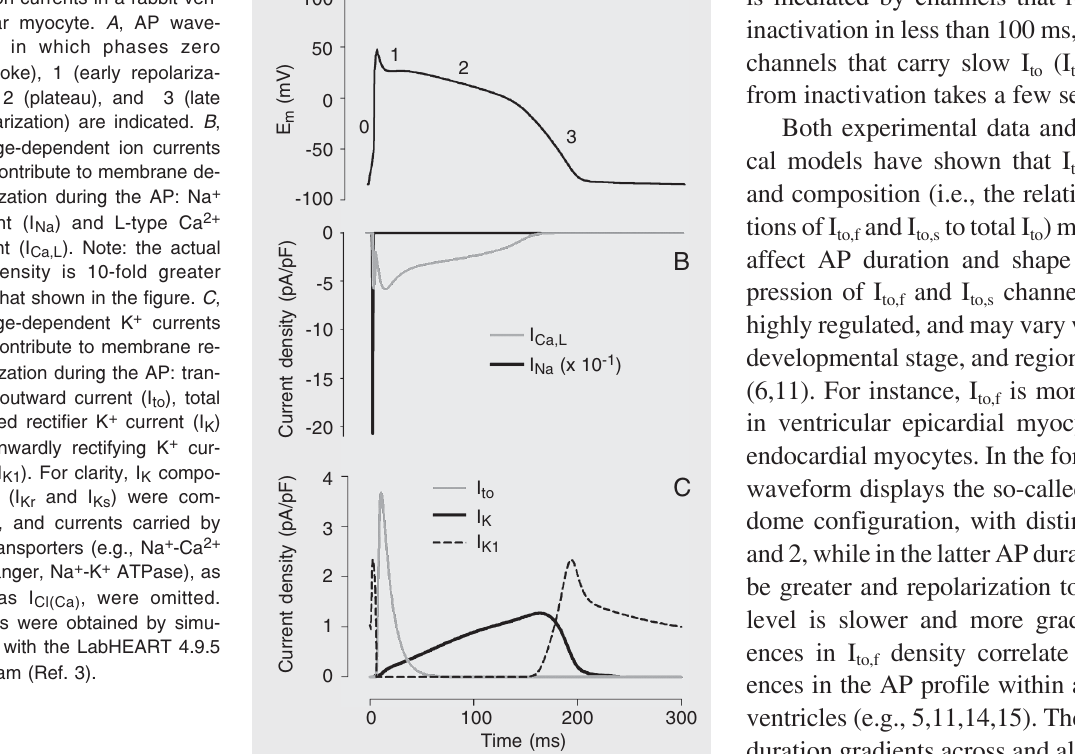
Figure 1. Action potential (AP) and ion currents in a rabbit ven- tricular myocyte. A , AP wave- form, in which phases zero (upstroke), 1 (early repolariza- tion), 2 (plateau), and 3 (late repolarization) are indicated. B , Voltage-dependent ion currents that contribute to membrane de- polarization during the AP: Na + current (I Na ) and L-type Ca 2+ current (I Ca,L ). Note: the actual I Na density is 10-fold greater than that shown in the figure. C , Voltage-dependent K + currents that contribute to membrane re- polarization during the AP: tran- sient outward current (I to ), total delayed rectifier K + current (I K ) and inwardly rectifying K + cur- rent (I K1 ). For clarity, I K compo- nents (I Kr and I Ks ) were com- bined, and currents carried by ion transporters (e.g., Na + -Ca 2+ exchanger, Na + -K + ATPase), as well as I Cl(Ca) , were omitted. Traces were obtained by simu- lation with the LabHEART 4.9.5 program (Ref.